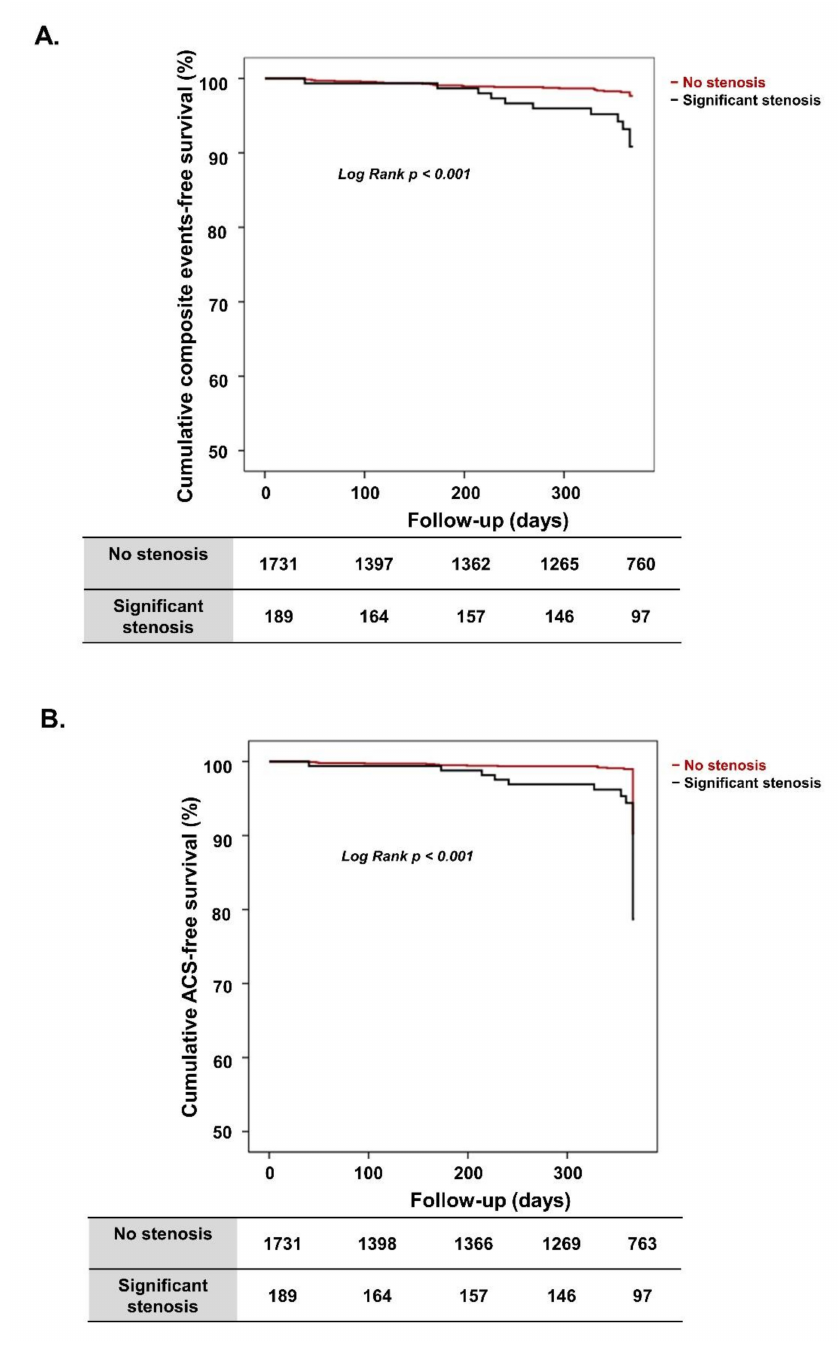
Figure 1. Kaplan–Meier survival curves for the entire population. ( A ) Cumulative composite event-free survival according to presence of significant stenosis. ( B ) Cumulative ACS-free survival according to presence of significant stenosis. ACS, acute coronary